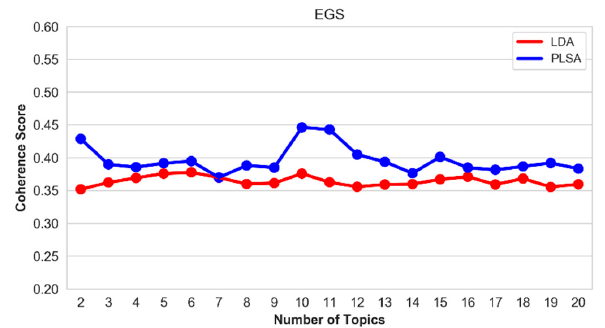
Figure 13. Coherence score of the top-20 topics on the EGS hallmark.